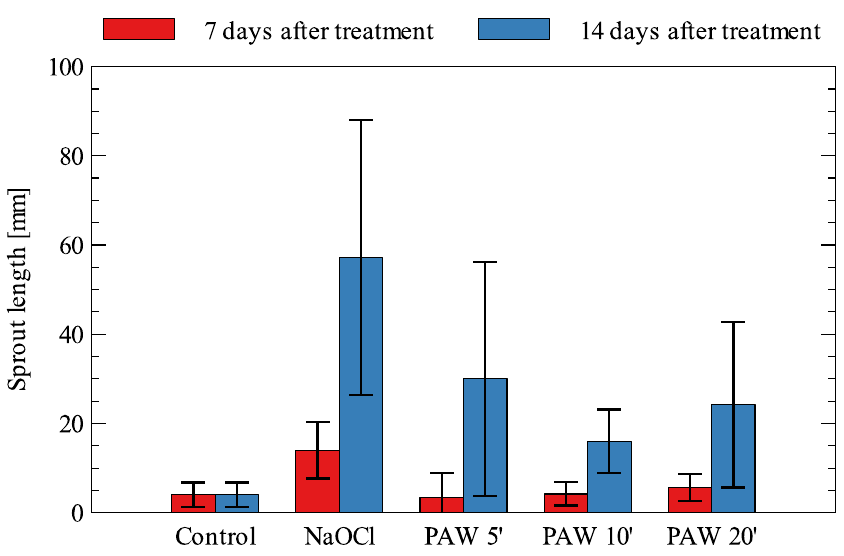
Figure 5. Sprout length of Daucus carota (mean values and standard deviation).